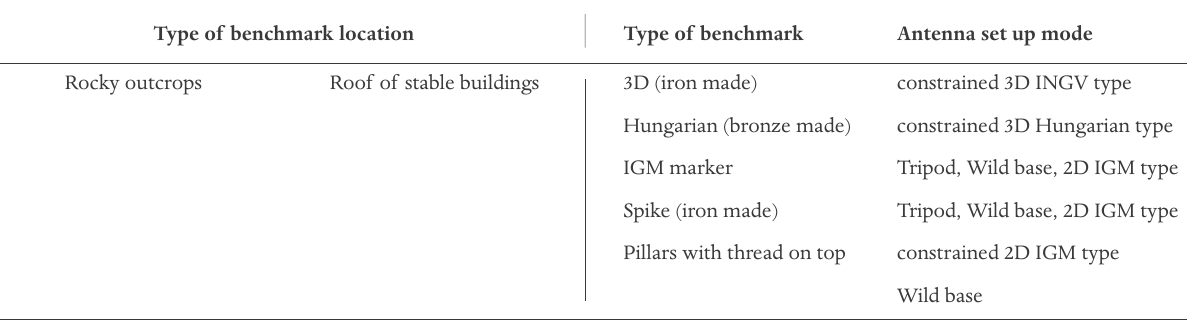
Table 1. Type of benchmark location, type of benchmark and mode of antenna set up used for the GPS discrete networks in the Aeolian